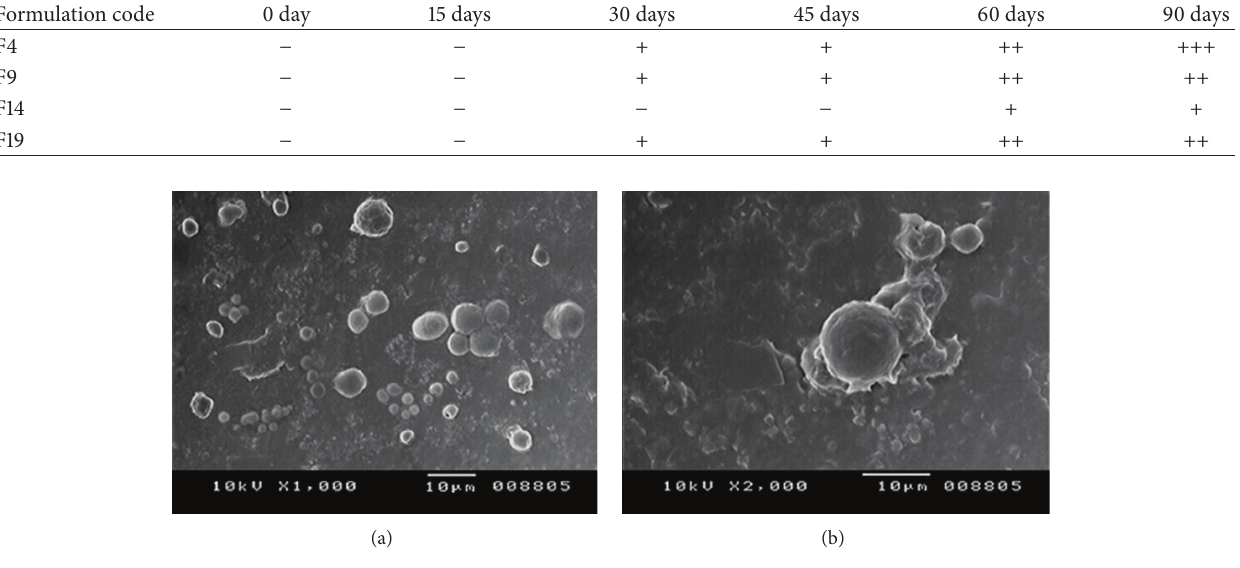
Figure 1: (a) SEM image of TDF loaded niosomes, (b) spherical structure of niosome at higher magnification.